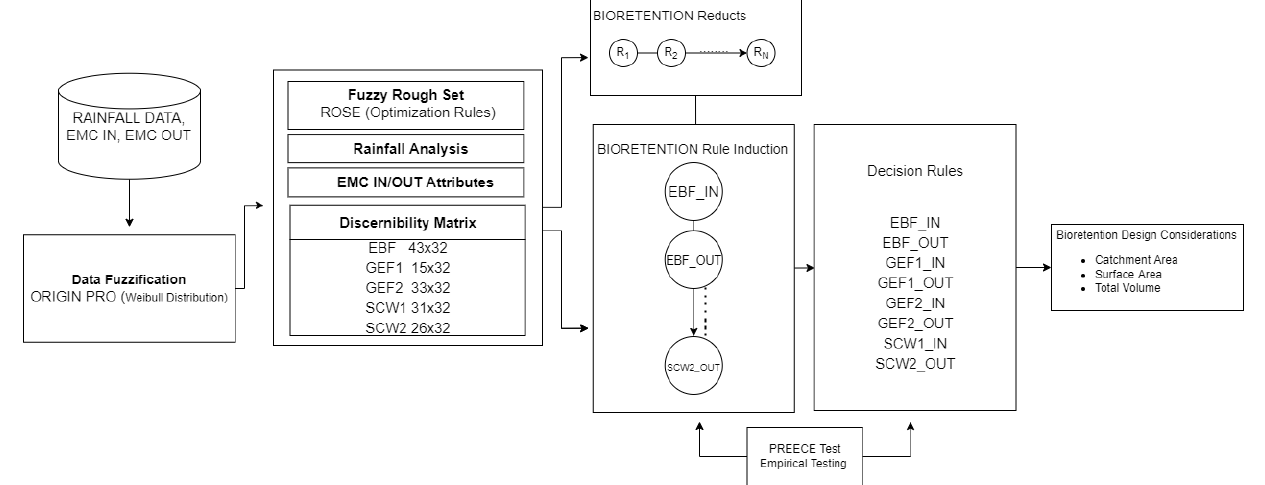
Figure 1. Methodological framework on the optimization of rules.